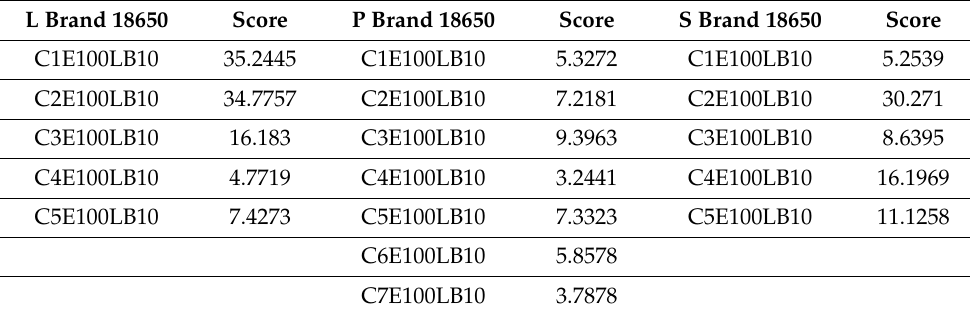
Table 4. Results of LSTM, Epoch = 100, look_back =